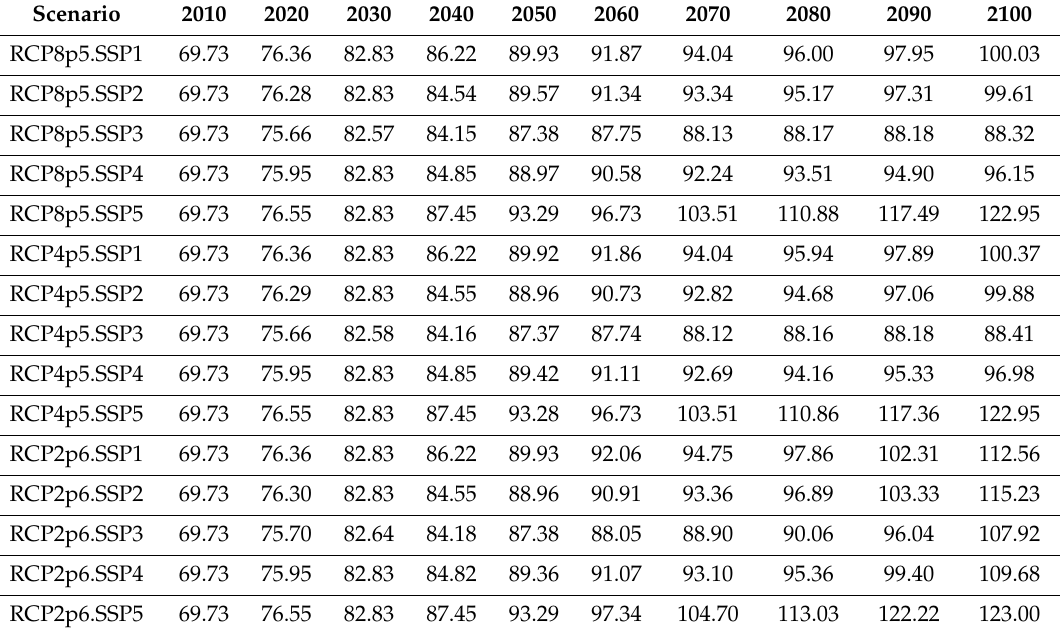
Table A1. Total national harvest (millions of m 3 / year, excluding bark, harvesting losses and branches).